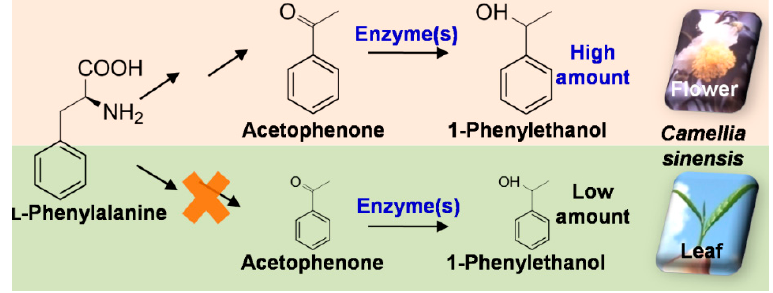
Figure 5. Proposed schematic model of differential accumulation of 1PE in flowers and leaves of tea ( Camellia sinensis ) plants.